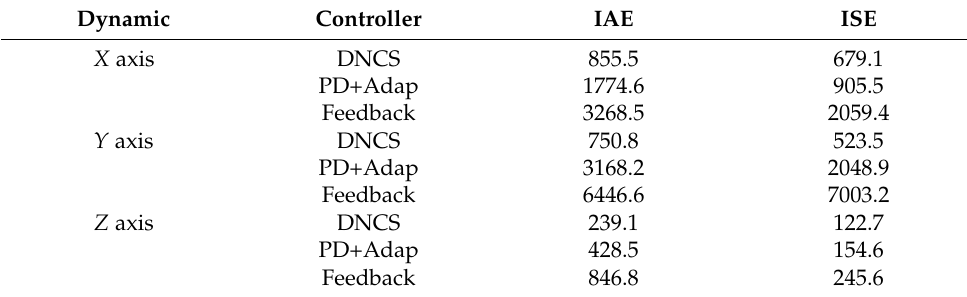
Table 4. Performance index comparison for 3D helical trajectory tracking.